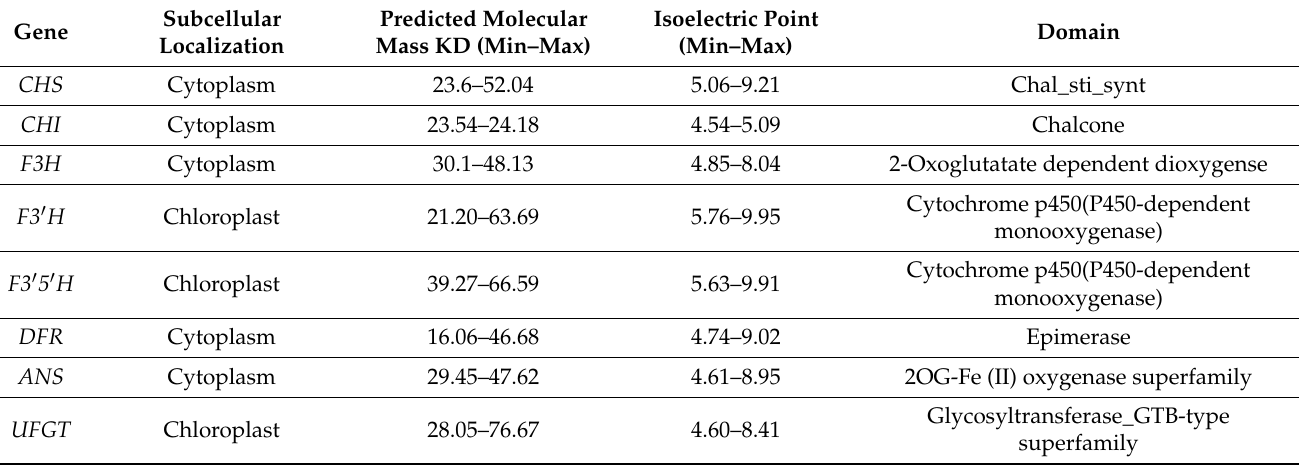
Table 2. Physiochemical properties and identified domains in the structural genes of anthocyanin biosynthesis pathway in wheat.